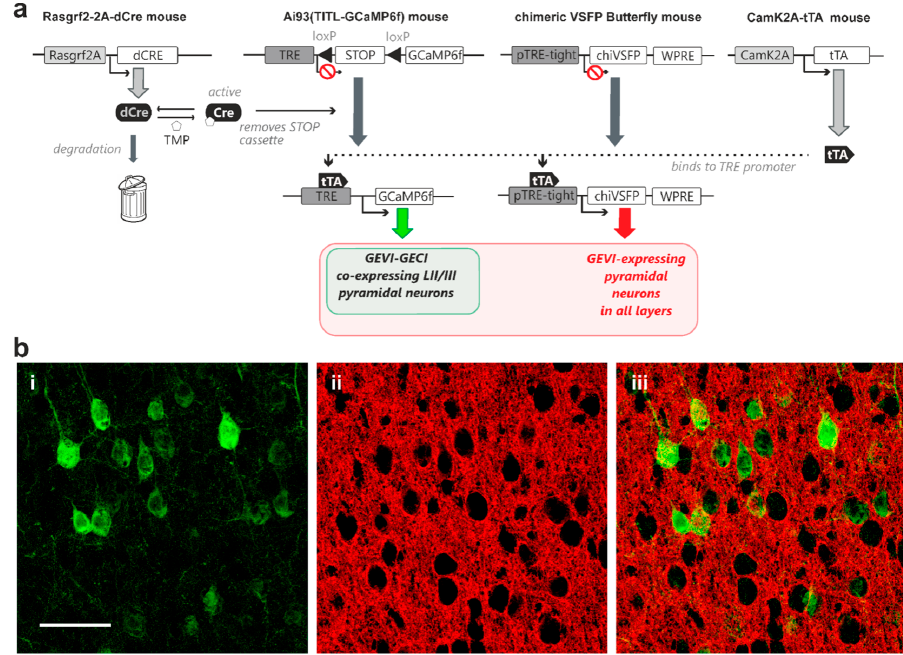
Figure 4. Expression of genetically encoded voltage indicator (chimeric VSFP Butterfly) in all cortical pyramidal neurons with controlled co-expression of genetically encoded calcium indicator (GCaMP6f) in layer II/III pyramidal neurons in vivo. ( a ) A transactivator, driven by CaMK2A promoter (CaMK2A-tTA) in pyramidal neurons, is required for binding to the TRE promoter for transcription activation in both chimeric VSFP Butterfly and Ai93 indicator mice. A STOP cassette removal using TMP-stabilized Cre-recombinase driven by Rasgrf2-2A promoter (Rasgrf2-2A-dCre) is only needed for the Ai93 line. This quadruple transgenic strategy therefore achieves full GEVI expression in all pyramidal neurons, with TMP dose-dependent adjustable GECI co-expression in layer II/III pyramidal neurons ( bi ) Strong GCaMP6f fluorescence signal observed in perisomatic regions of individual pyramidal neurons ( bii ) A single confocal plane image showing strong chimeric VSFP Butterfly fluorescence signal from pyramidal neurons observed across all cortical layers ( biii ) Merged GCaMP6f (green) and chimeric VSFP Butterfly (red) fluorescence signals showing adjustable sparse GECI indicator expression over dense GEVI expression patterns. Scale bar = 50 µm.